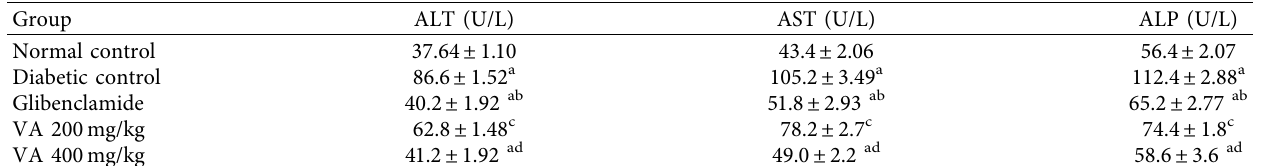
Table 3: Effect of V . album extract on serum liver markers level in alloxan-induced diabetic animals.